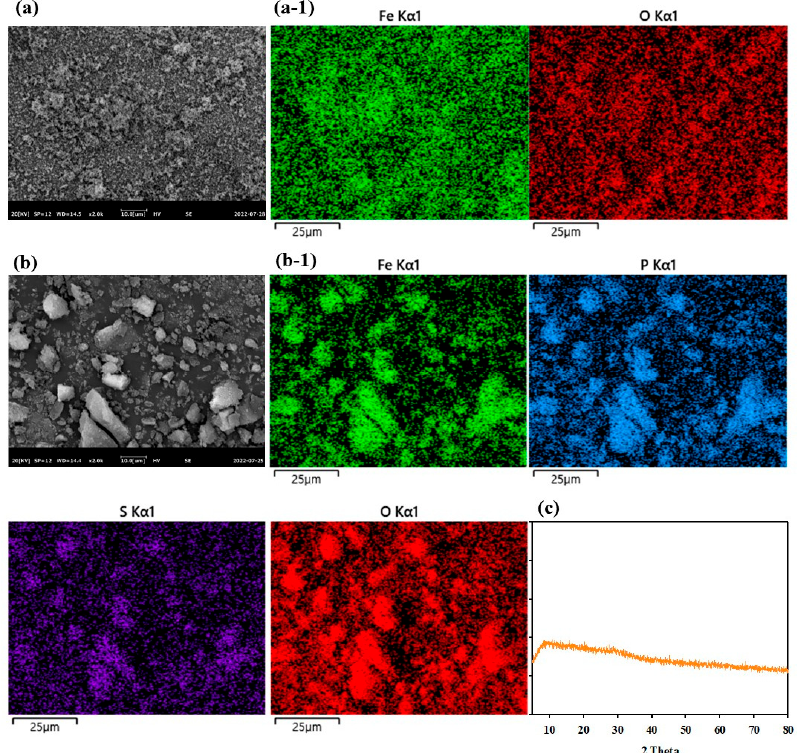
Figure 7. SEM-EDS analysis of ( a ) pure lepidocrocite, ( b ) the precipitates after T-P removal by L-Fe dissolved solution with H 2 SO 4 , and ( c ) XRD results of precipitates after T-P removal by lepidocrocite- H 2 SO 4 solution. EDS electron mapping for different conditions ( a-1 , b-1